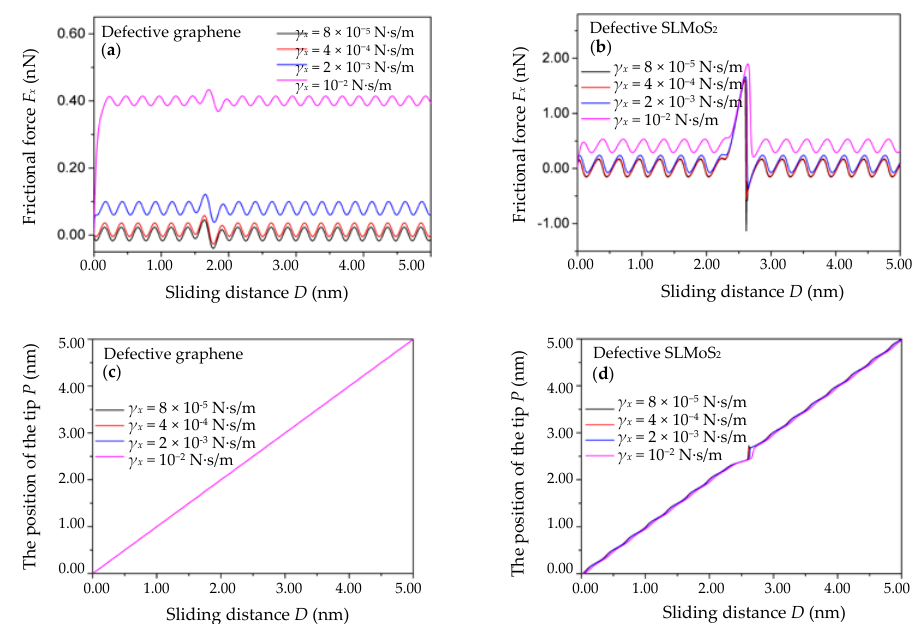
Figure 4. The frictional force F x vs. the sliding distance D curves of the monovacancy-defective graphene ( a ) and SLMoS 2 ( b ) with di ff erent dampings γ x of the system. The position of the single-atom tip P vs. the scanning distance D curves of the monovacancy-defective graphene ( c ) and SLMoS 2 ( d ) with di ff erent dampings γ x of the system. The curves in Figure 4 look like a single curve, but they are the overlap of multiple curves, and the displayed curves are the pink curves.